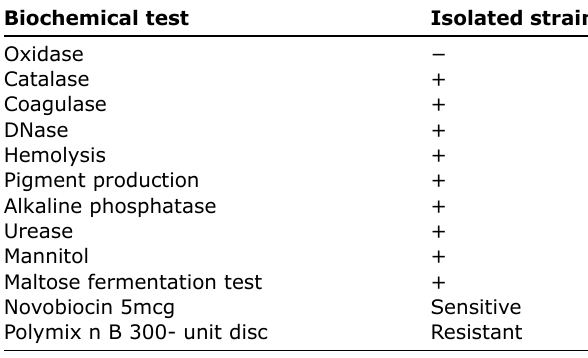
Table-1: Biochemical reactions of isolated S. aureus from dogs’